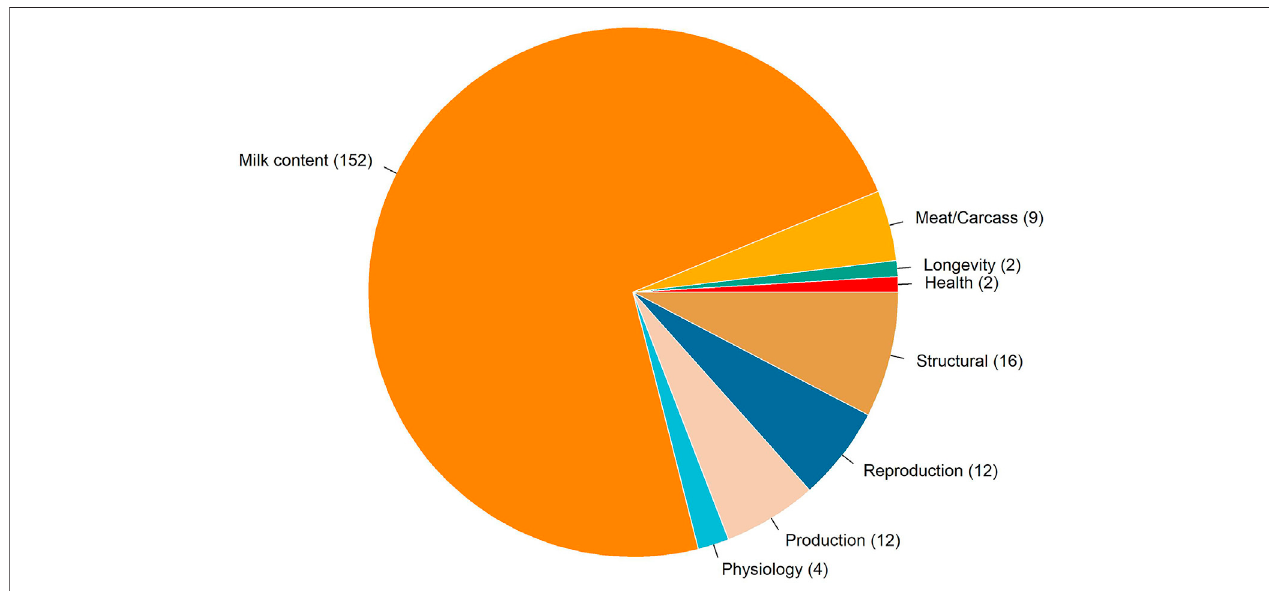
FIGURE 4 | Chart of the trait-types associated with the quantitative trait loci overlapping with the genomic regions associated with